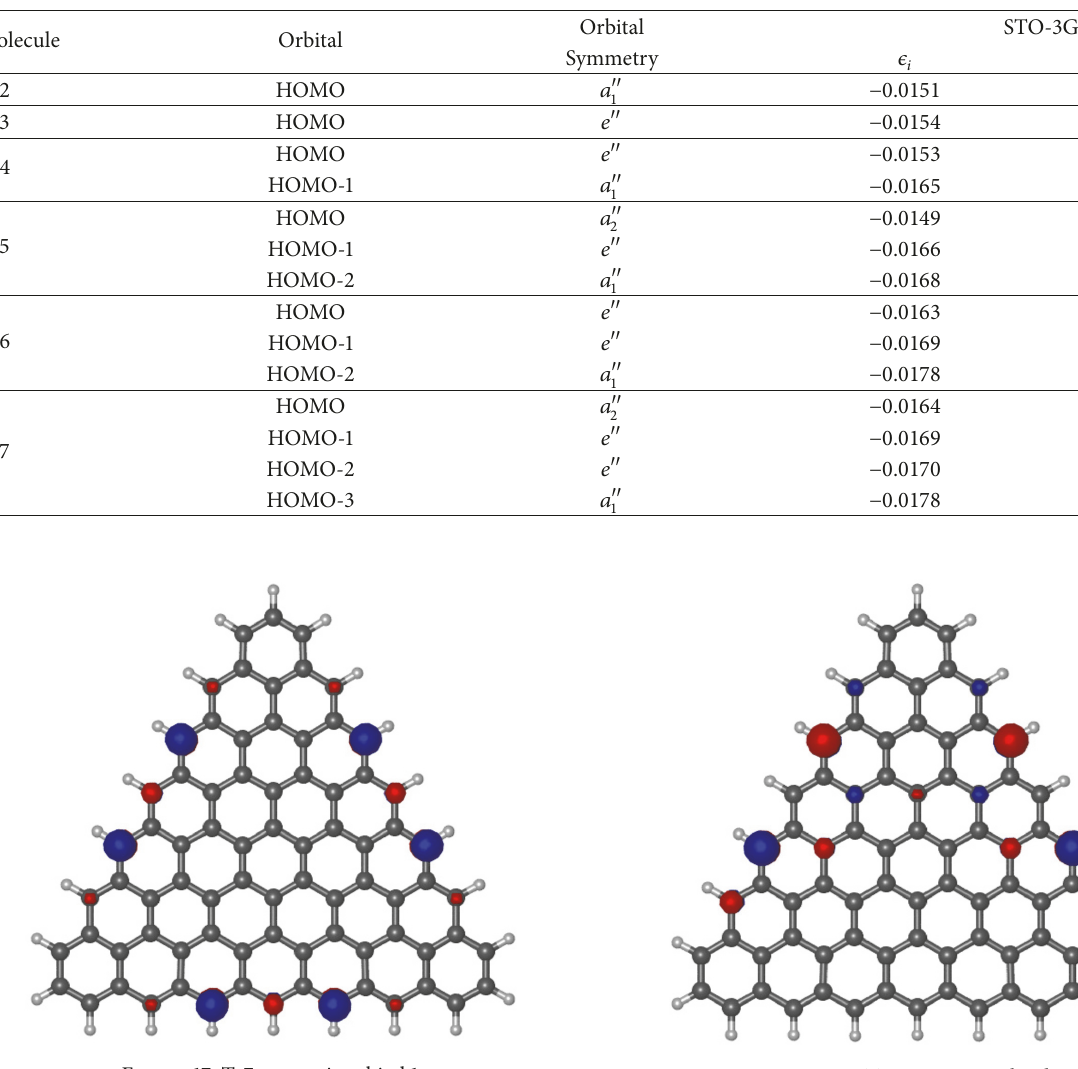
Figure 19: T 7 magnetic orbital